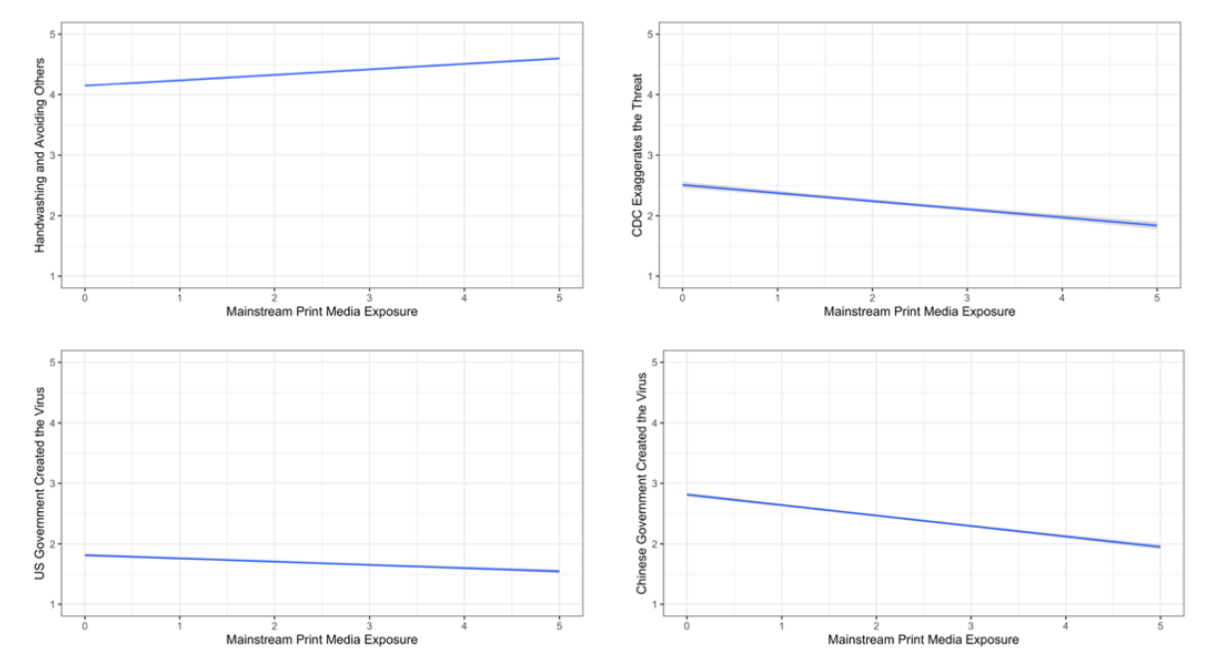
Figure 2. Associations between Mainstream Print Media Exposure and Information/Misinformation